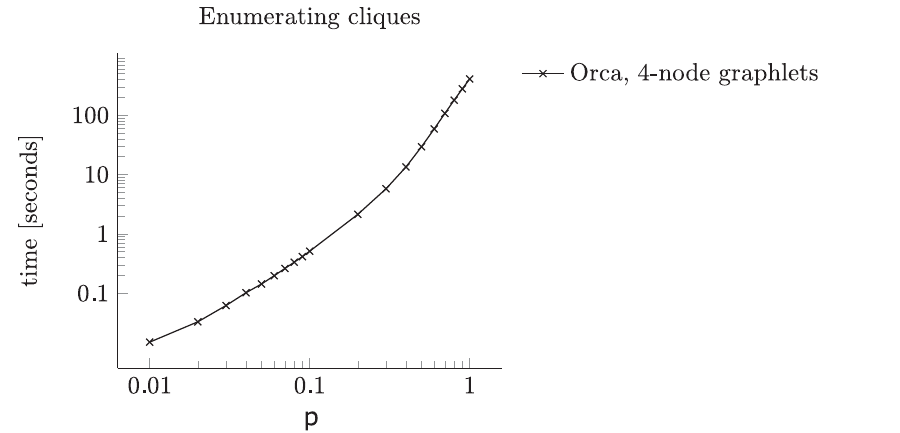
Fig 11. Enumerating cliques. The effect of enumerating cliques on running times in randomgraphs of increasing